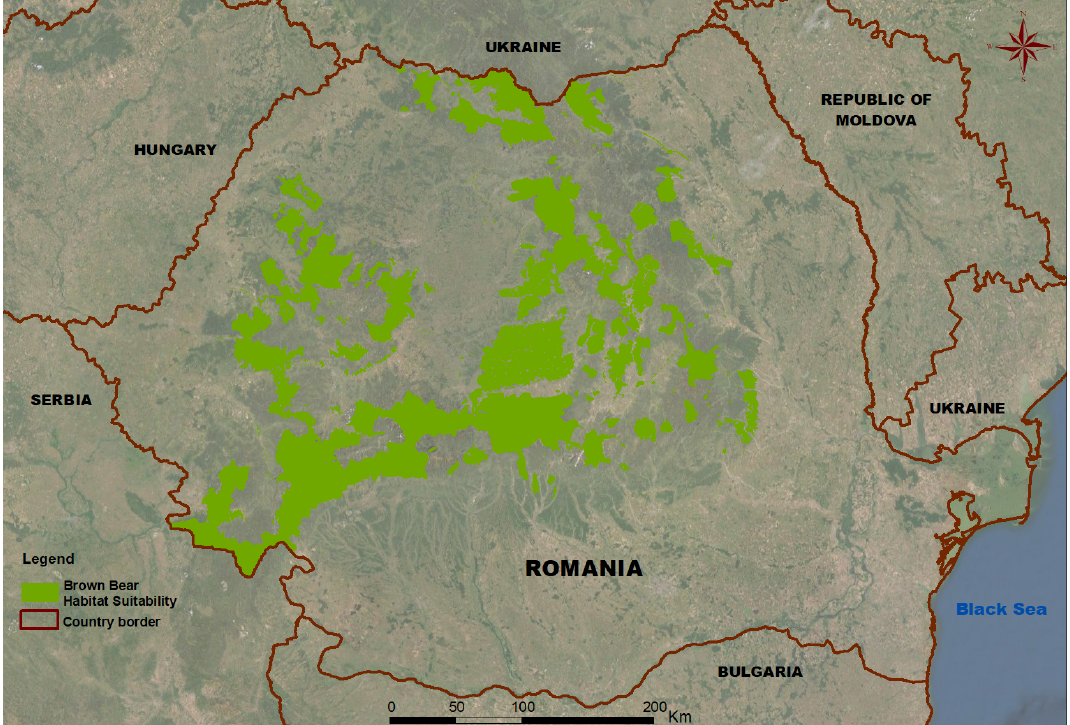
Figure 3. Map of habitat suitability for the brown bear in Natura 2000 sites from the Romanian Carpathian Mountains. The favorable habitat is represented by core areas (large areas that meet the requirements for permanent occurrence of the brown bear).